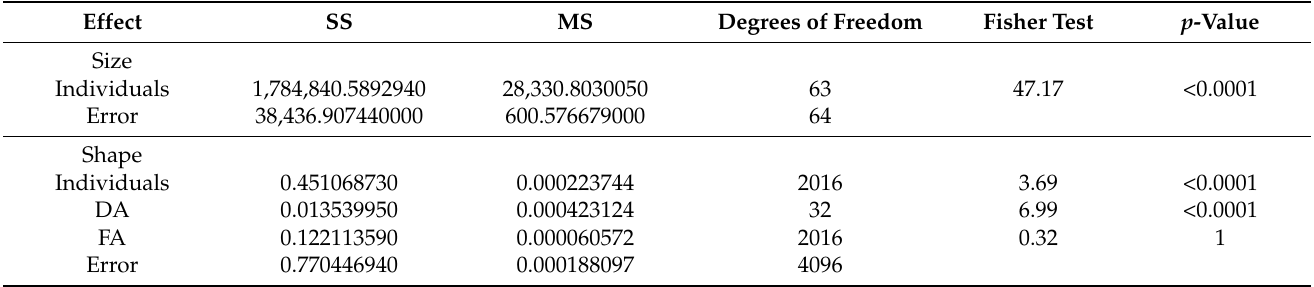
Table 1. Measurement error Procrustes ANOVA for size and shape of carapace symmetry for Testudo n = 64), with a significant effect of DA (Directional Asymmetry) for size and shape. Pillai trace was significative for DA (Pillai trace = 0.86; p < 0.0001) but also for FA (Fluctuating Asymmetry) (Pillai trace = 17.42; p < 0.0001). Sums of squares (SS) and mean squares (MS) are in units of Procrustes distances